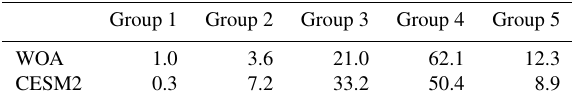
Table 4. The percentage of clustered water in the total ocean volume in the